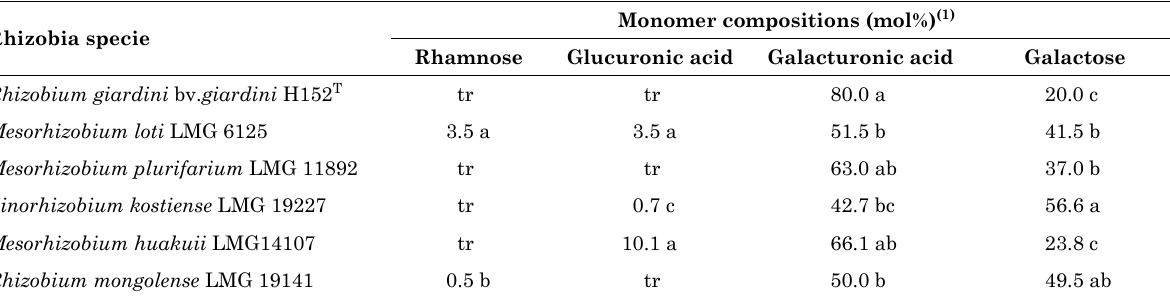
table 1. Monomer compositions of exopolysaccharides produced by different rhizobia species cultured in Rhizobium defined medium (RDM) for 6 days at 30 °C rhizobia